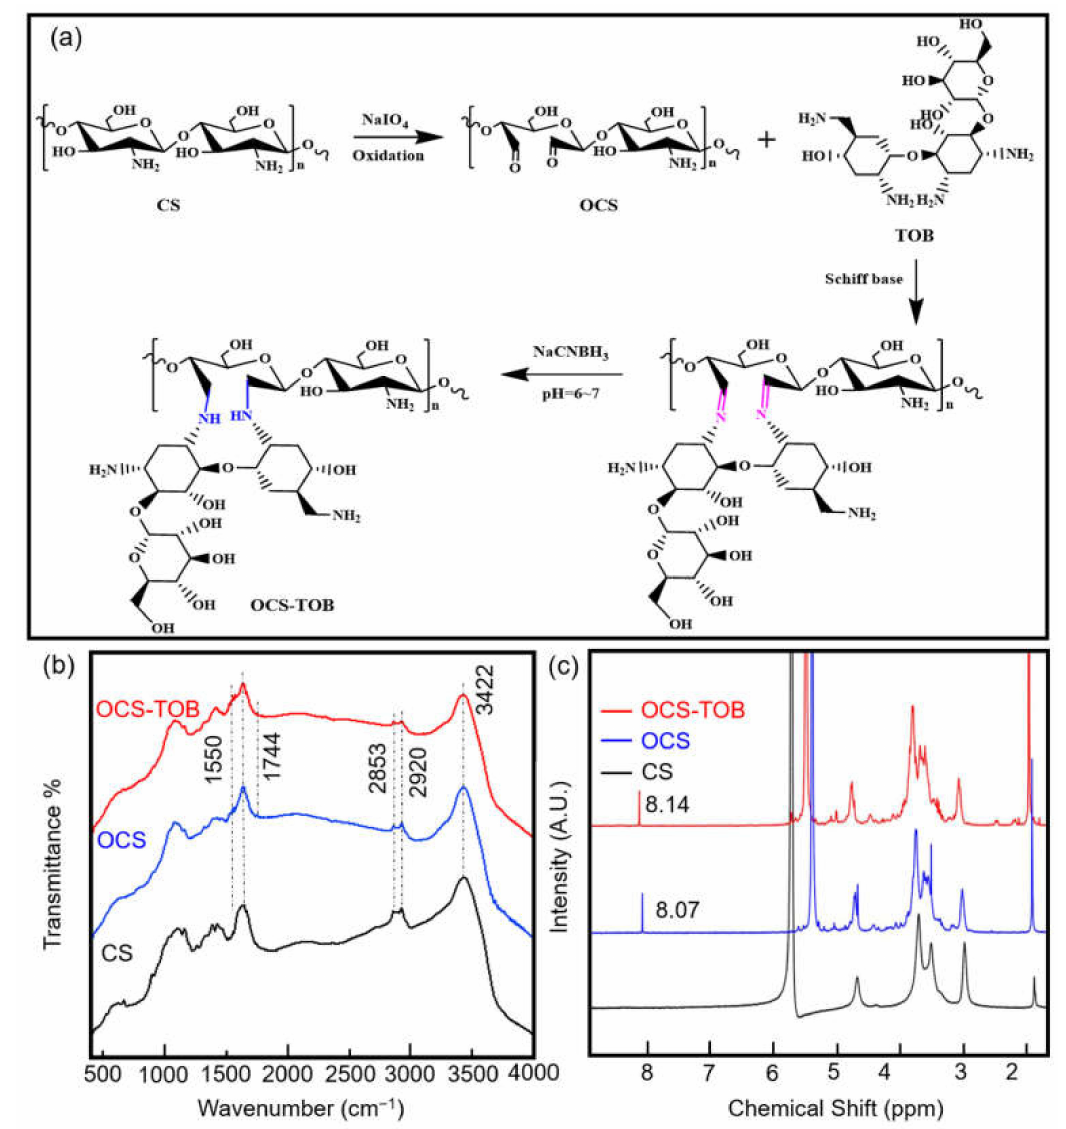
Figure 1. Synthesis of OCS-TOB procedures ( a ); FTIR curves ( b ) and 1 H NMR spectrum ( c ) of CS, OCS and